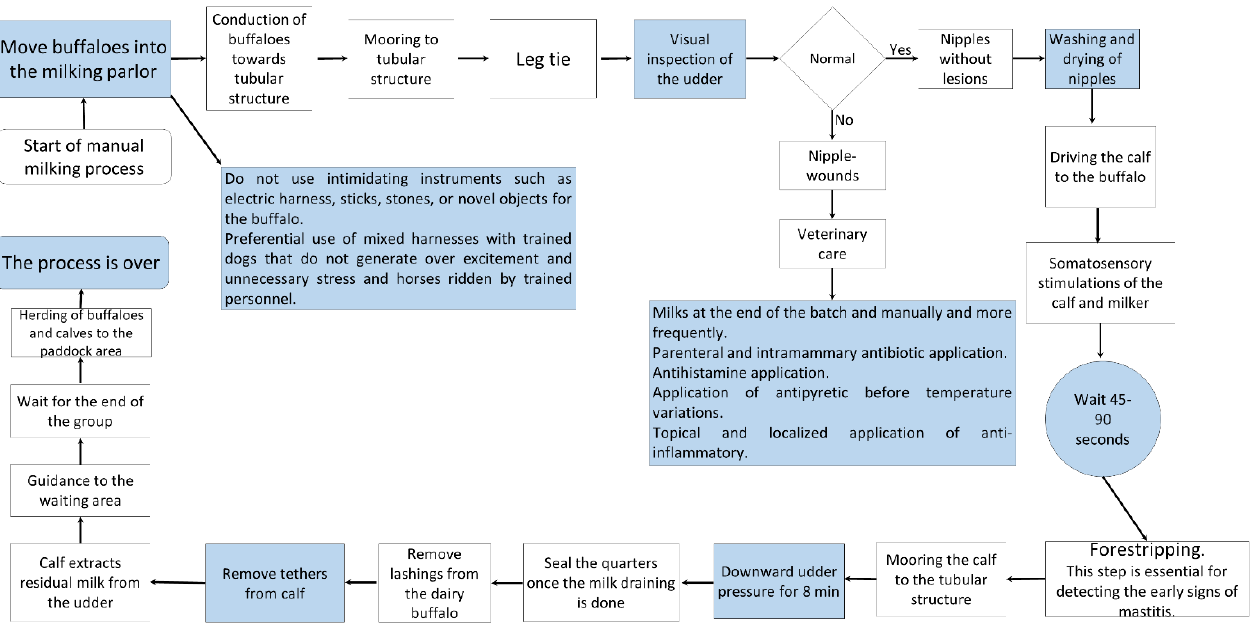
Figure 10. Flow chart of the characteristics of manual milking. In the dual-purpose production system, the presence of clinical or subclinical mastitis is low; however, if it occurs, veterinary care is necessary.